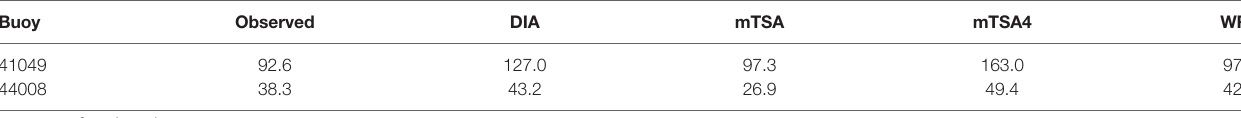
TABLE 3 | Observed maximum 2-D wave spectra for Hurricane Teddy, compared to simulations. Buoy Observed